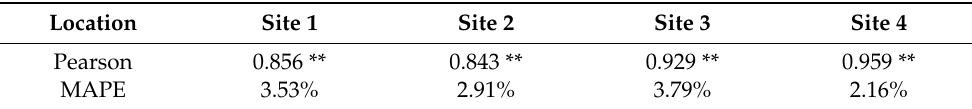
Table 5. Pearson correlation coefficient and mean absolute percentage error (MAPE) of observed and simulated